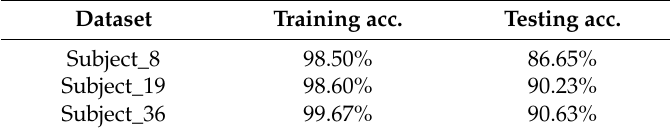
Table 7. Accuracy of different numbers of training and testing.